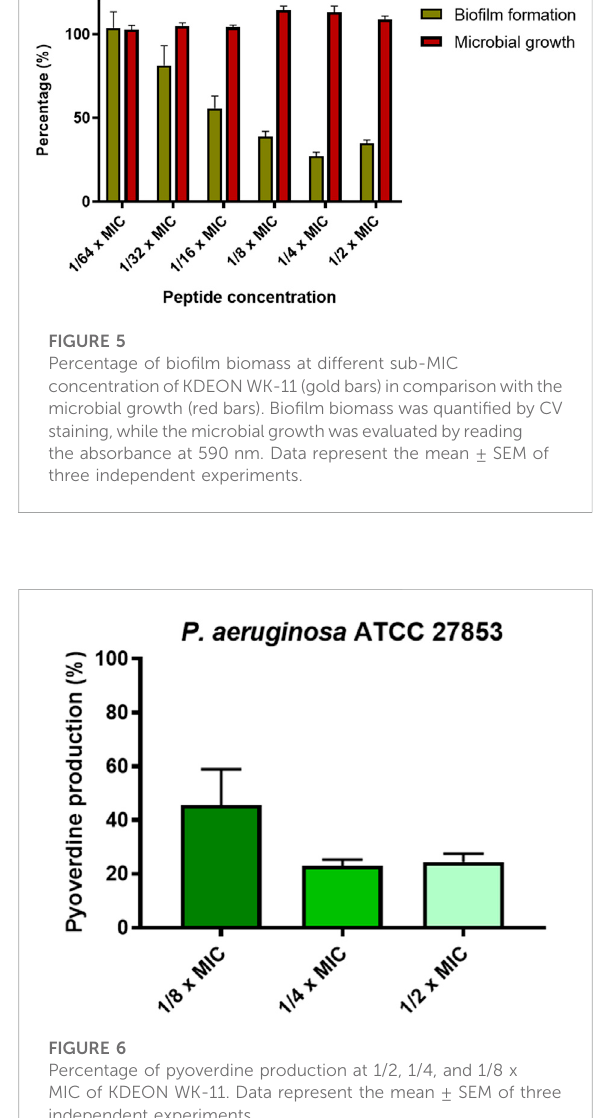
Figure 4, KDEON WK-11 was active against P. aeruginosa bio fi lm and at 6.25 μ M, reduced approximately 40% of bio fi lm metabolic activity. Of particular signi fi cance, when tested at 25, 50 and 100 μ M the percentage of bio fi lm metabolic activityy was lower than 20%.